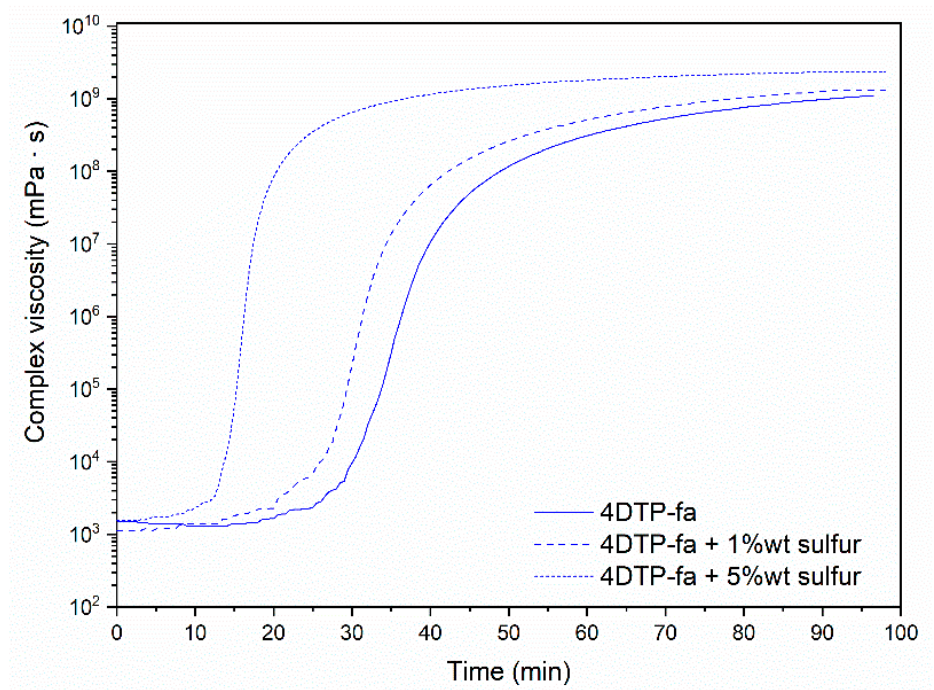
Figure A27. Curing behavior of 4DTP-fa with 0, 1, and 5 %wt of sulfur by rheo-kinetics measurement at 150 °C followed by complex viscosity over time.